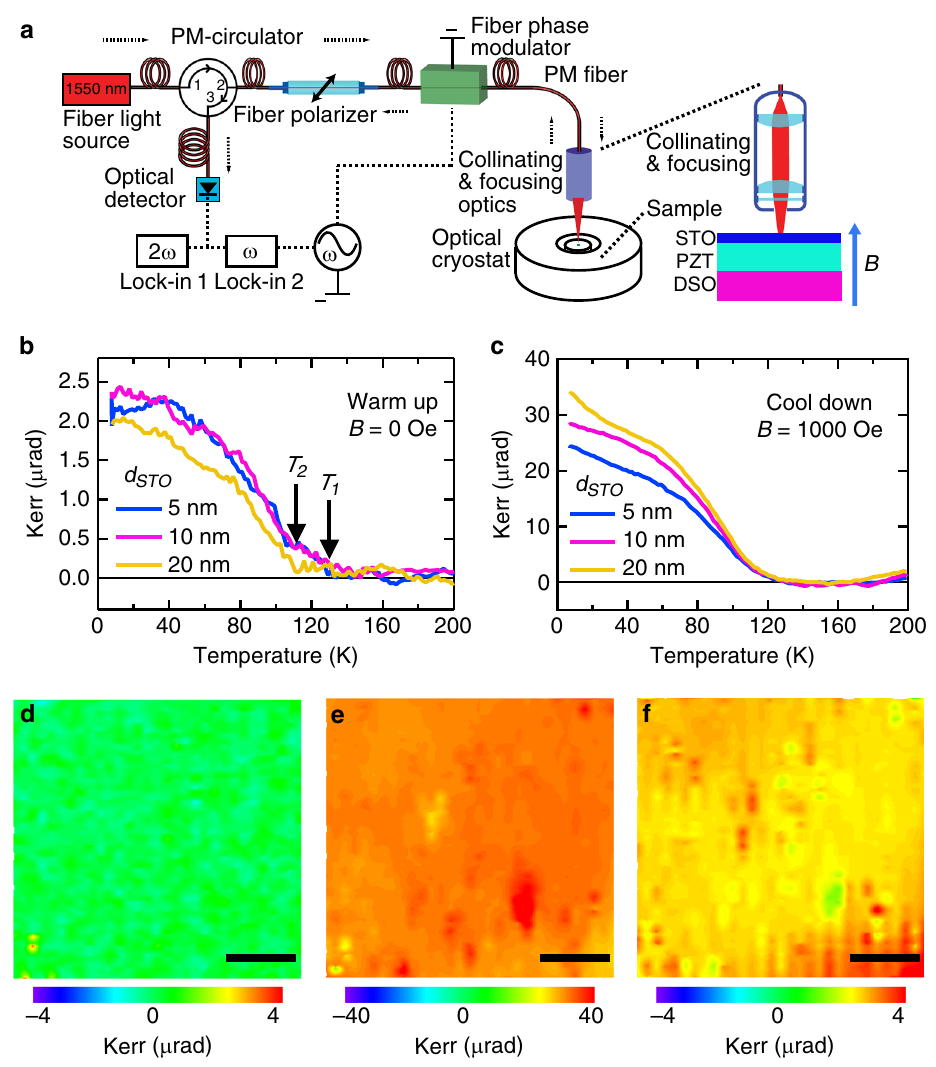
Fig. 3 Sagnac interferometer and MOKE measurements. a Schematics of the all- fi ber Sagnac interferometer. b Kerr effect during 0 Oe warmup and ( c ) 1000 Oe cool-down for three STO (5, 10, 20 nm)/PZT/DSO samples with the same 50 nm PZT thickness. d Kerr signal image mapping over a 60 × 60 μ m 2 scan area in the STO (5 nm)/PZT/DSO sample at 130 K. Scale bar, 15 μ m. e , f Kerr signal image mapping in the same region at 4 K under 1000 Oe and 0 Oe fi eld, respectively, both showing uniform ferromagnetism signal distribution. Scale bar, 15 μ